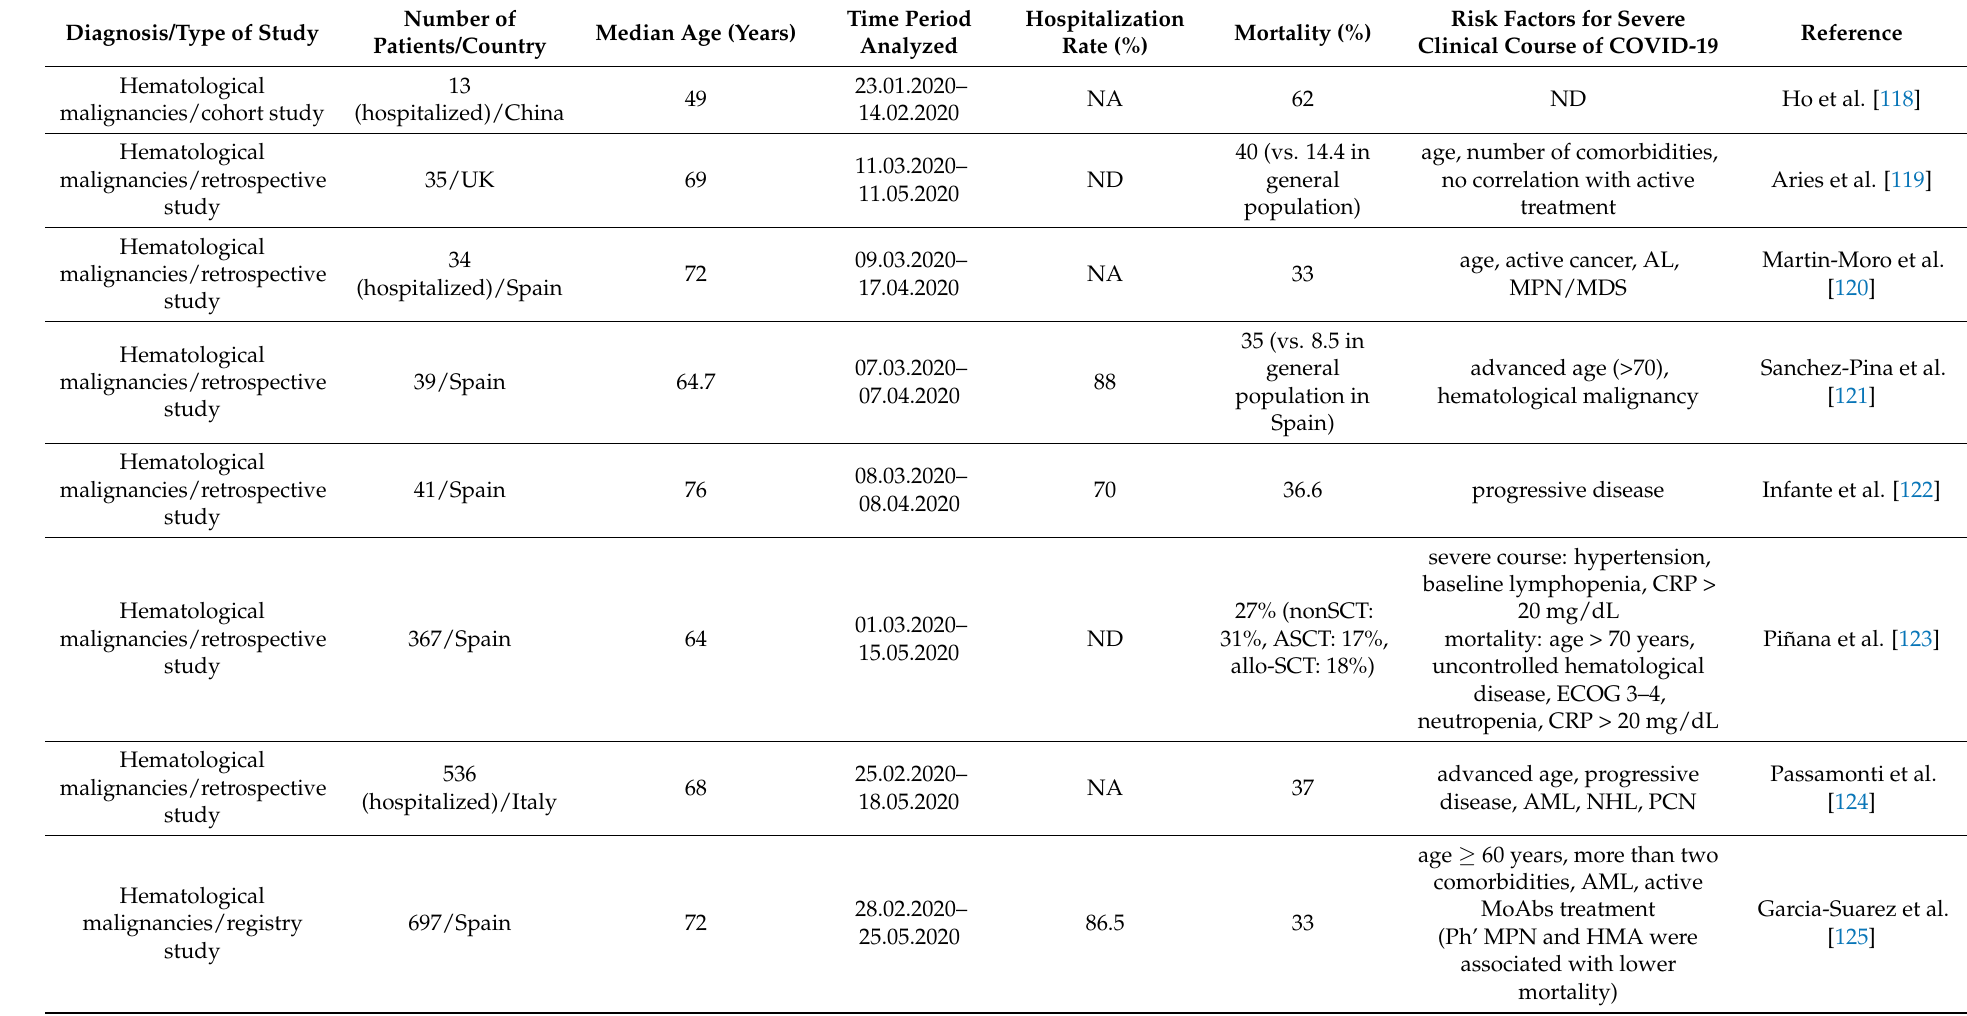
Table 3. Incidence, clinical course and risk factors for severe course of COVID-19 in patients with hematological